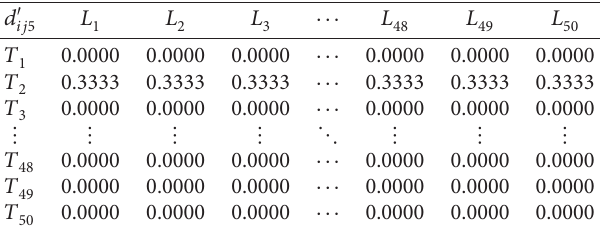
Table 33: Perceived utility matrix V b ′ � [ d ij ′ ] for 4 4 50 × 50 housing matching.